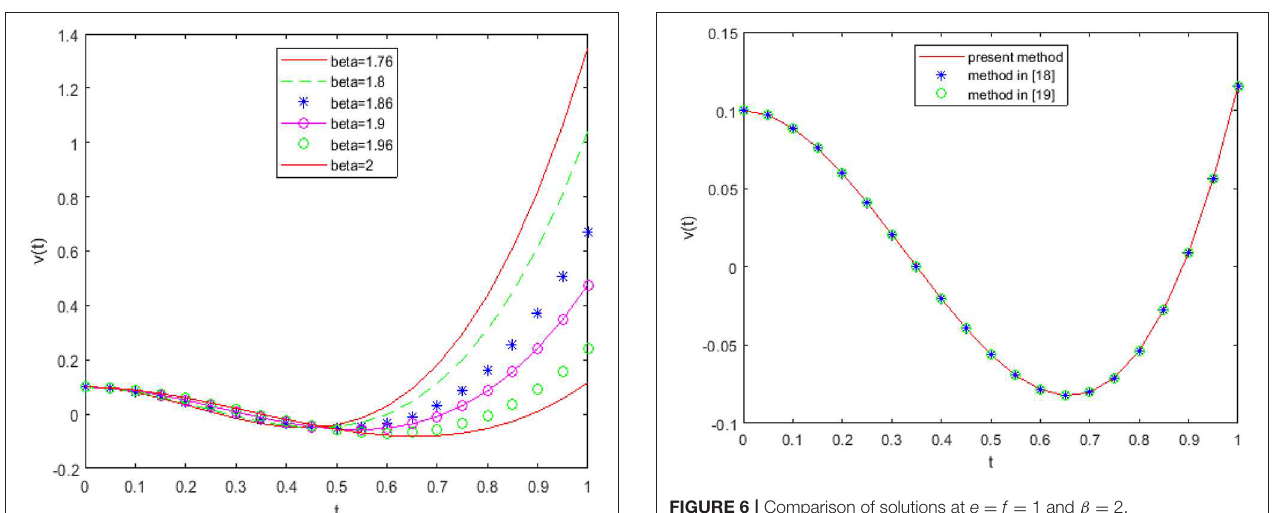
FIGURE 6 | Comparison of solutions at e TABLE 3 | Comparison between results by our proposed method and DTM [40] for fractional Duffing equation at β t Method in Nourazar and Mirzabeigy [40]